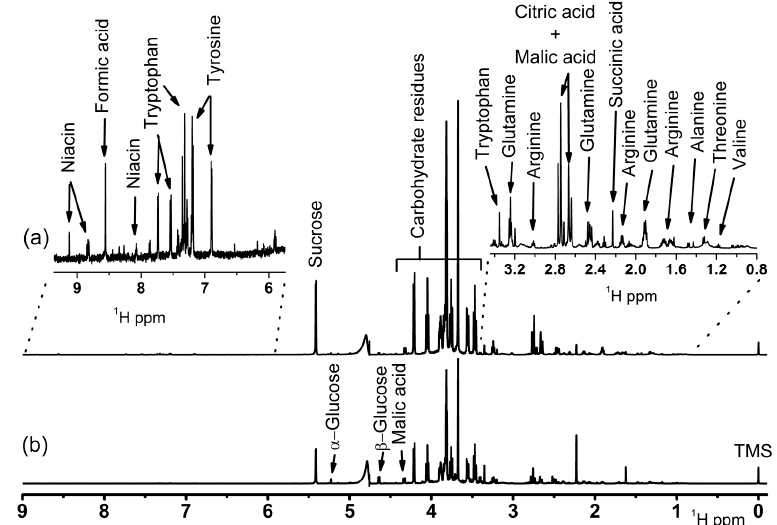
Figure 1. PC1 × PC2 Comparison between the 1H NMR spectra from representative genotypes of cassava harvested after 9 months of planting: ( a ) ETC BRS Dourada and ( b ) HTC hybrid 2009_1220.